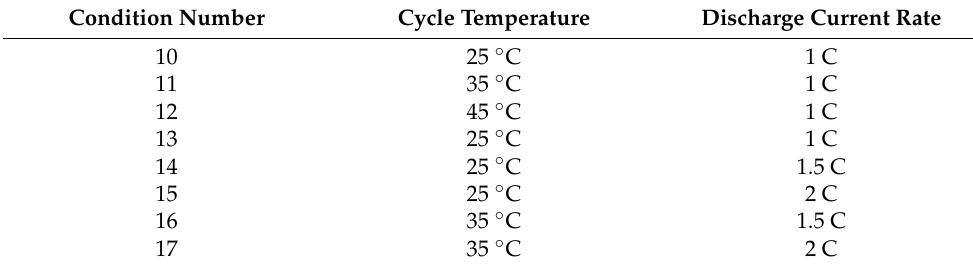
Table 3. Cycle life conditions of Battery